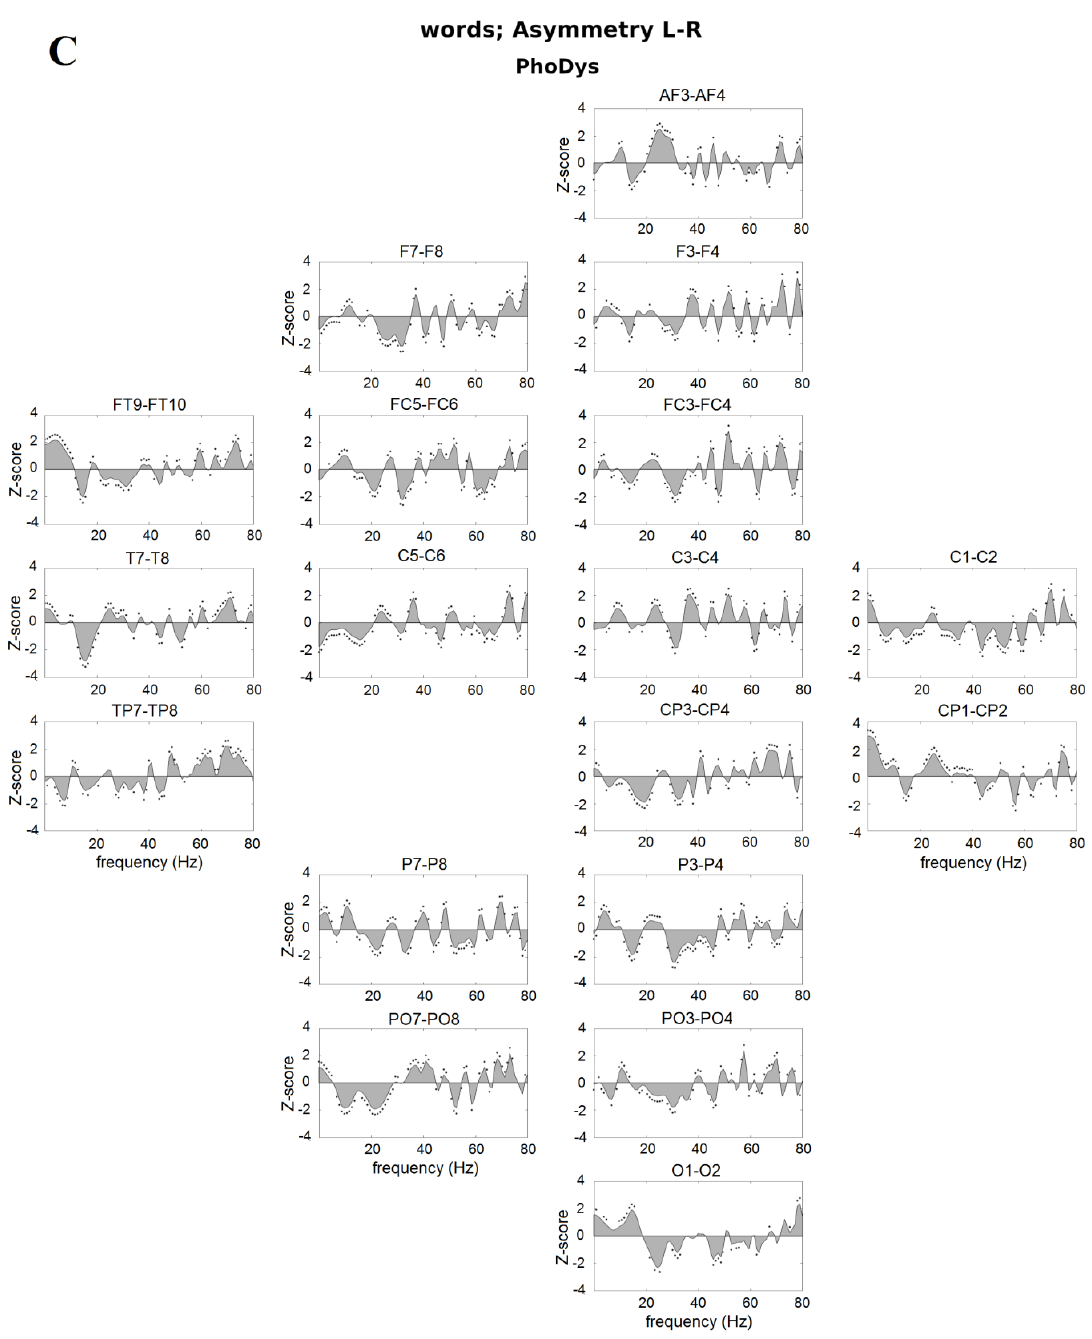
Figure 1. Hemispheric asymmetry of speech–brain entrainment for ( A ) controls, ( B ) NoPhoDys, and ( C ) PhoDys when word listening (left-right hemisphere). Points indicate statistically significant differences (nonparametric bootstrap, p < 0.05). The speech–brain entrainment on respective left hemispheric areas is represented in the upper panel of the plots and right hemispheric areas—in the lower panel of the plots.